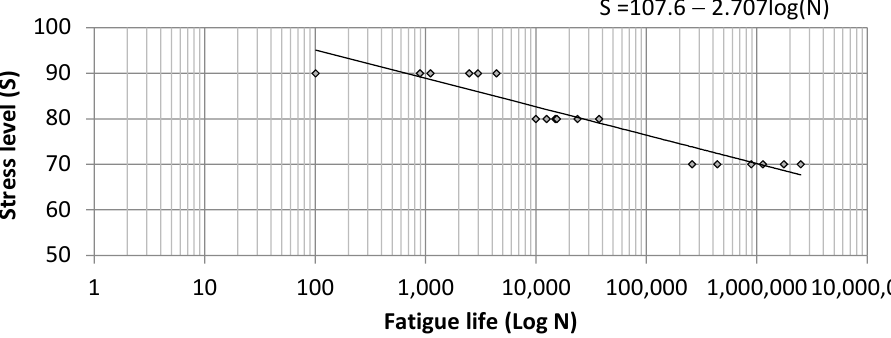
Figure 7. (S-log N) straight line interpolating the experimental data.